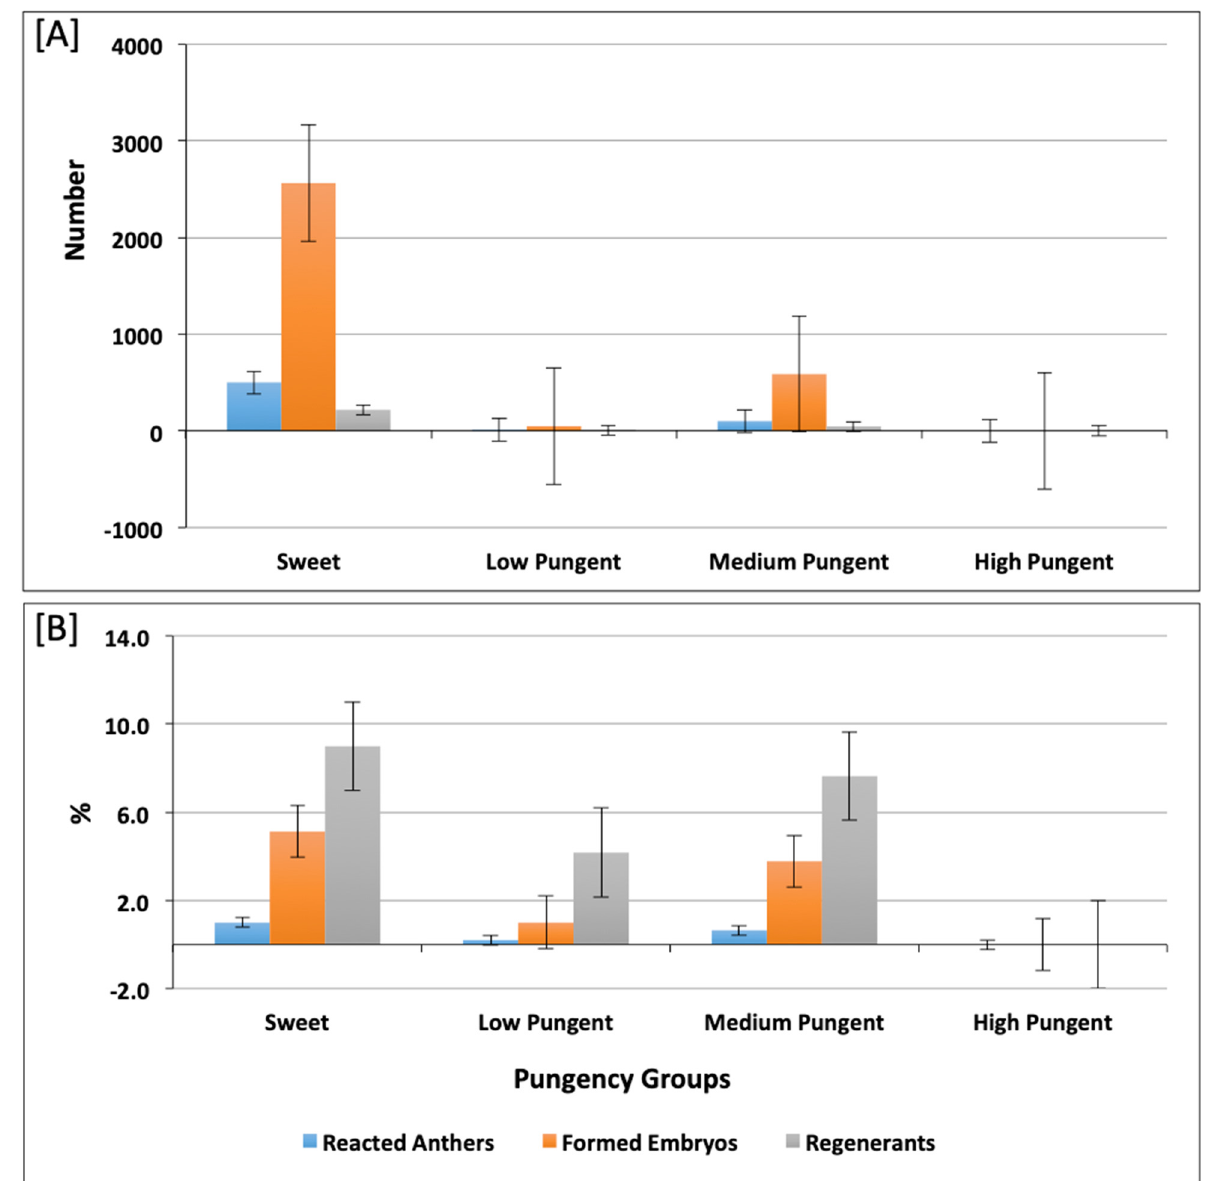
Figure 4. Histogram depicting reacted anthers, formed embryos, and embryo regenerants in accessions belonging to sweet, low pungent, medium pungent, and high pungent groups. The reacted anthers, formed embryos, and embryo regenerants measured in number and percentage (%) are shown in ( A , B ), respectively.